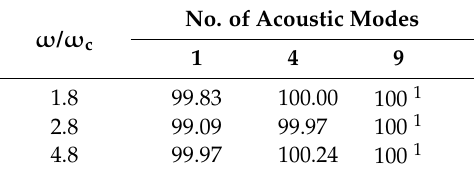
Table 2. Acoustic mode convergence study (1st level solution, number of structural modes = 2, l = 5 a , γ = 4).